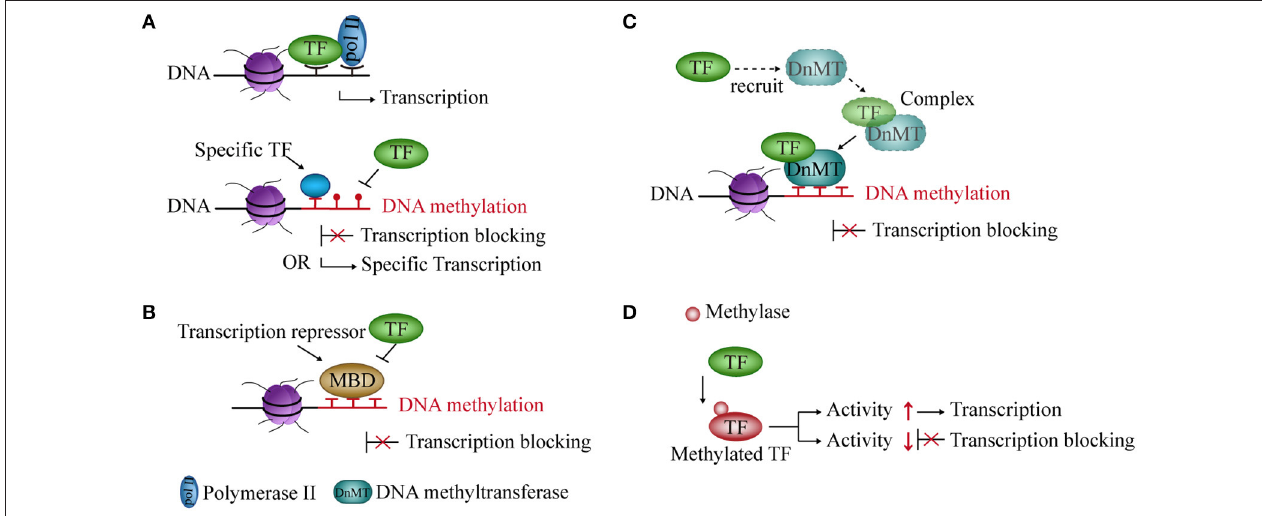
FIGURE 1 | Interaction between DNA methylation and transcription factors (TFs). (A) Methylated DNA inhibits the binding of TFs to DNA but also creates binding sites for some specific TFs and activates transcription. (B) Transcriptional repressors occupy an mCpG site, thereby blocking transcription. (C) TFs recruit DNA methyltransferases to form a complex and repress transcription. (D) Methylase acts on TF and regulates its activity and transcription.